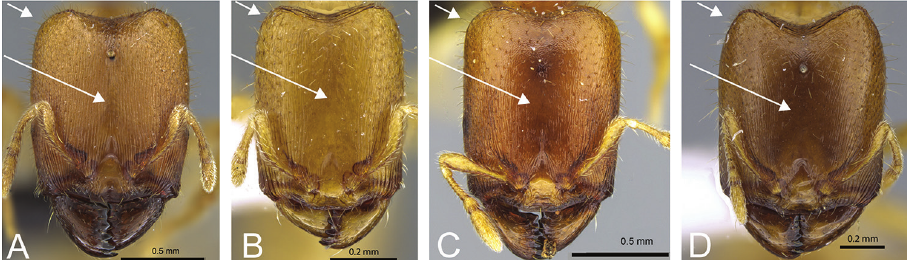
Figure 6. Head in full-face view of A Carebara placida (CASENT0070818) B Carebara bara (CASENT0439907) C Carebara hiragasy (CASENT0496886) D Carebara malagasy (CASENT0438154).